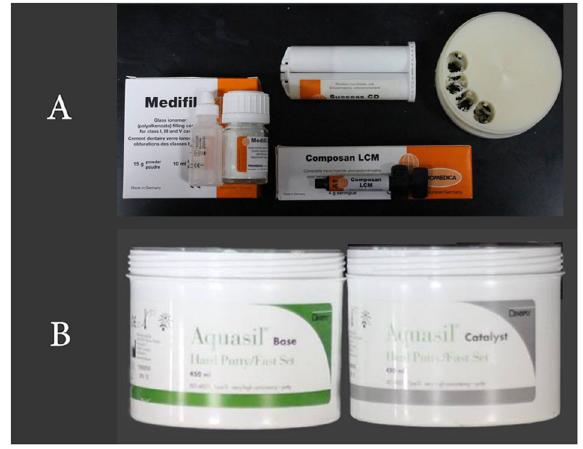
Fig. 2 Materials used. A Tested materials. B Addition